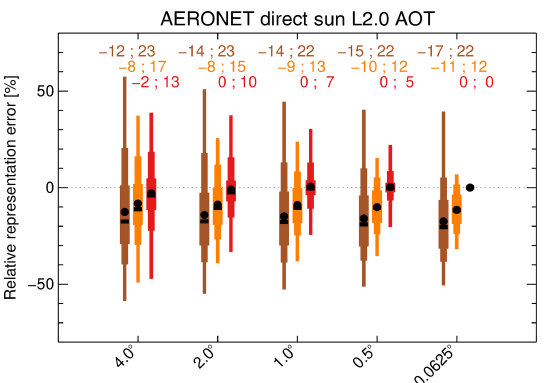
Figure 4. Yearly representation errors for AOT from AERONET direct sun L2.0 for different model grid-box sizes. The colours indi- cate different collocation protocols: yearly (brown), daily (orange) and hourly (red). Numbers on top are the means of the errors and means of the signless errors.